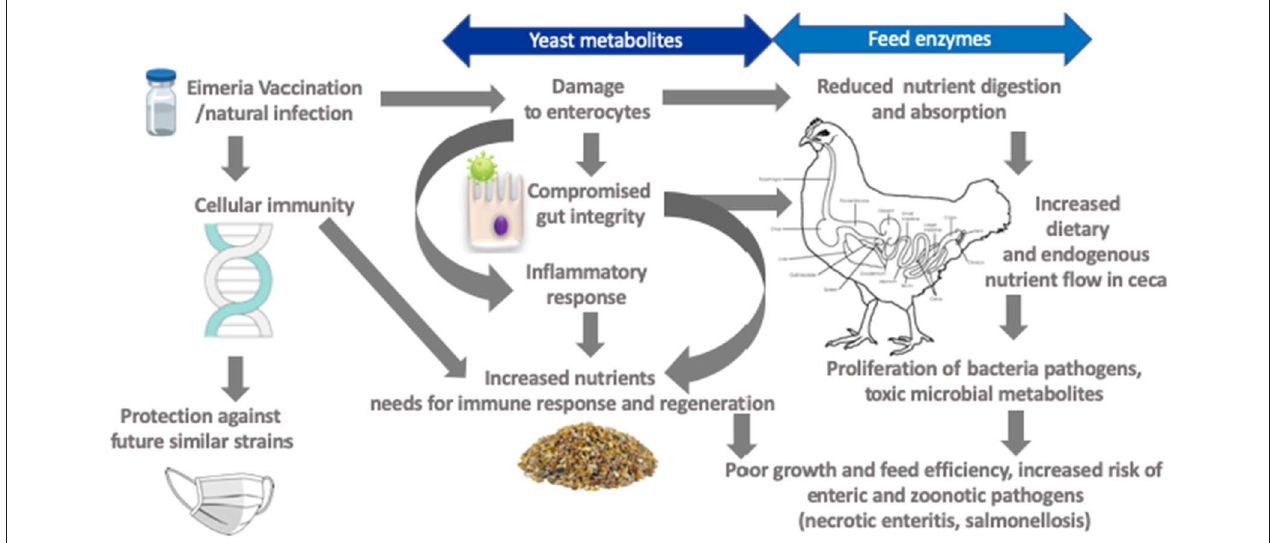
FIGURE 2 | Framework for targets amenable by yeast derivatives and feed enzymes in mitigating negative effects of